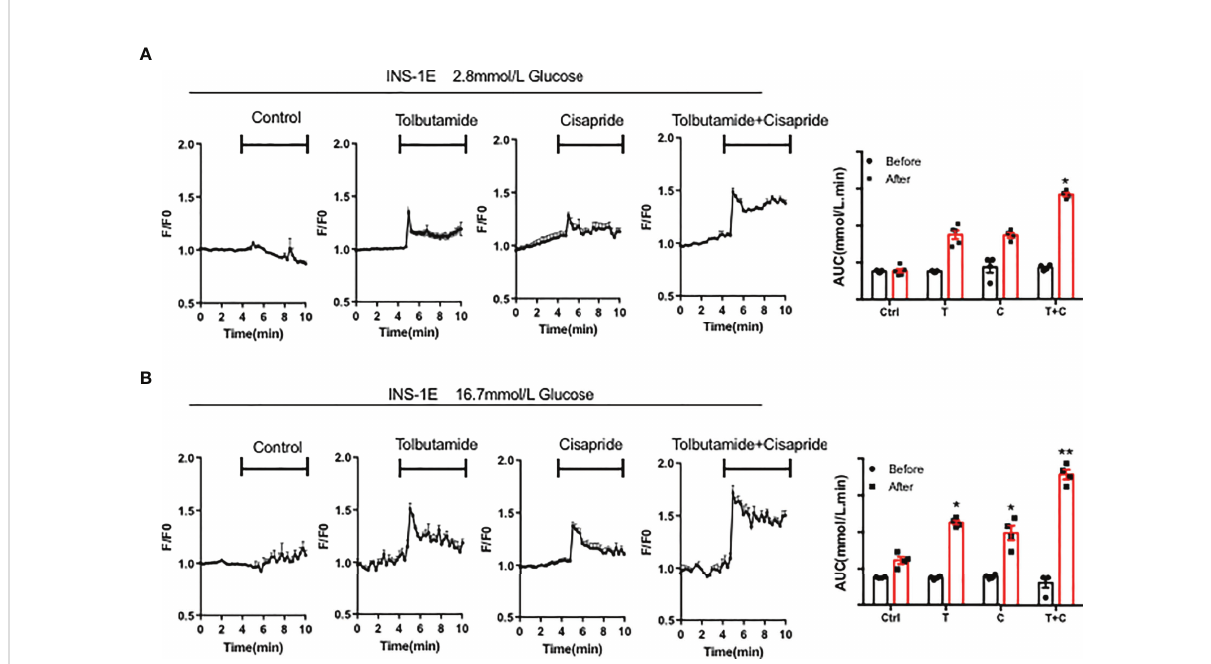
FIGURE 6 Cisapride affected the intracellular Ca 2+ concentration in INS-1E cells The intracellular Ca 2+ concentration was measured in the rat pancreatic cell line INS-1E treated with Control (Ctrl), 10 mM tolbutamide (T), cisapride (C) and tolbutamide+cisapride (T+C) under the stimulation with (A) 2.8 mM glucose and (B) 16.7 mM glucose for 5 min before the base line was stable for 5 min. PBS was used as a control. AUC was measured before (0-5 min) and after (5-10 min) different drugs application. n=4 (A-B) for each group. * P < 0.05, ** P < 0.005 vs. Ctrl. Statistical comparisons were calculated using the Wilcoxon matched paired-test (A, B)